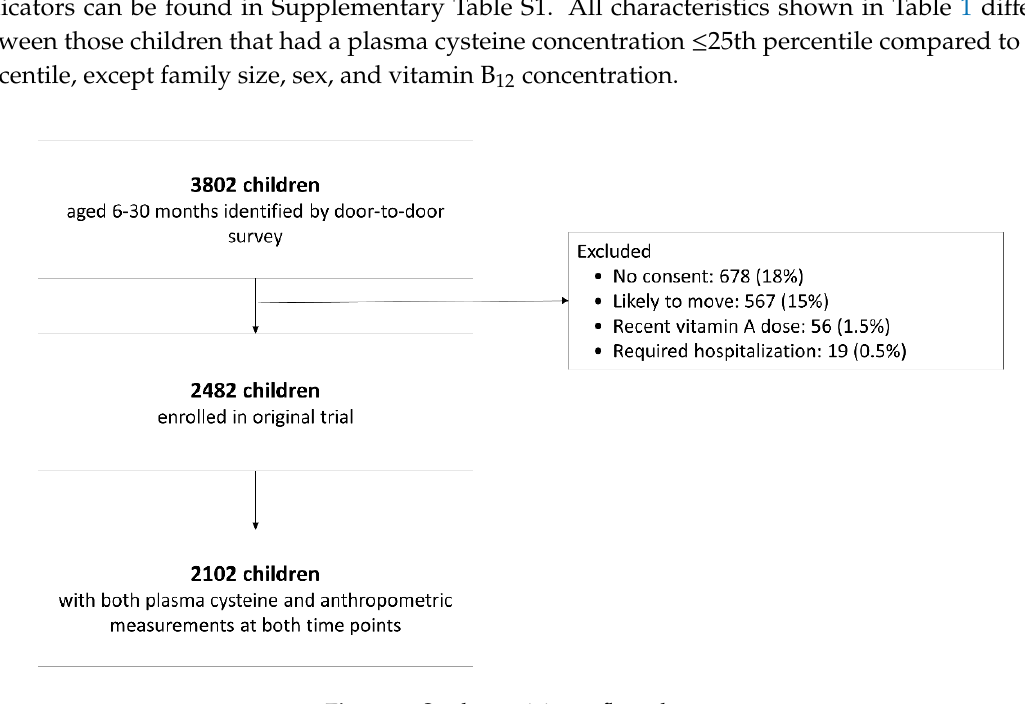
Figure 1. Study participant flow chart. Table 1. Baseline characteristics of 2102 children aged 6–30 months living in New Delhi, India included in the analysis.